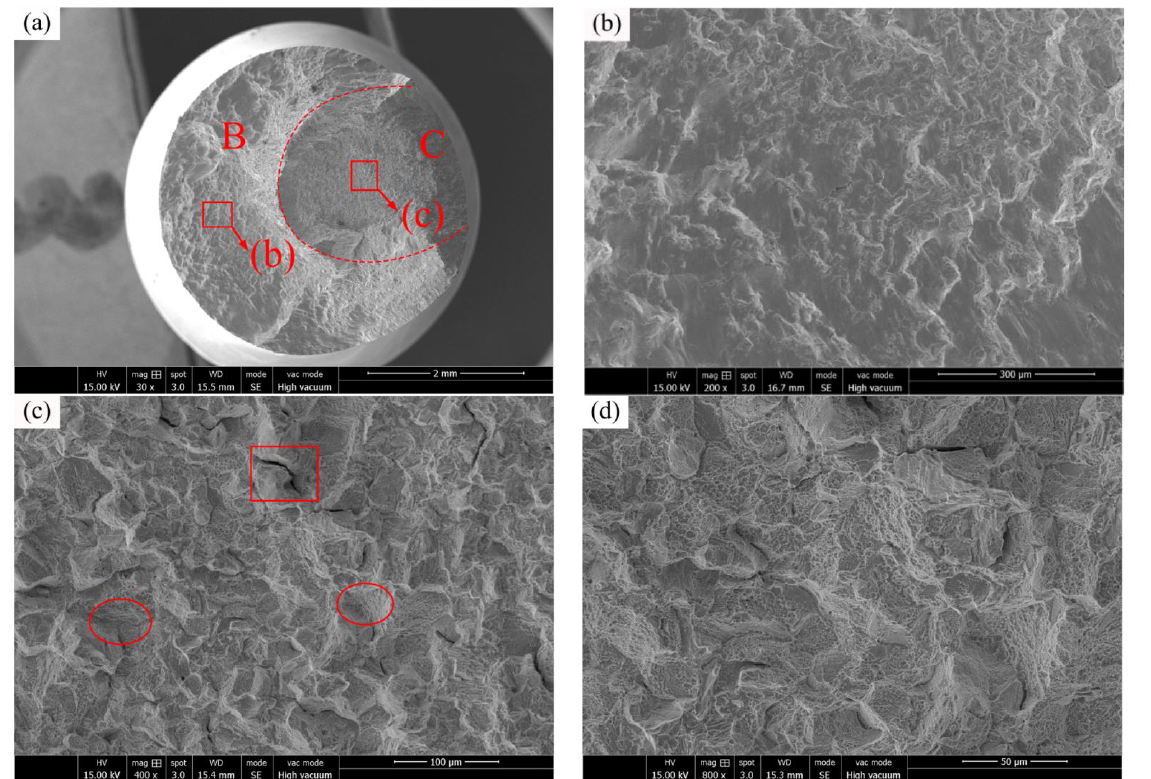
Figure 12. C17200 beryllium copper alloy fractured at 150 °C ( S max = 450 MPa, N f = 0.43 × 10 7 cycles). ( a ) General view of fatigue-fractured surface; ( b ) crack propagation region; ( c ) final rupture region; and ( d ) enlarged view of final rupture region.